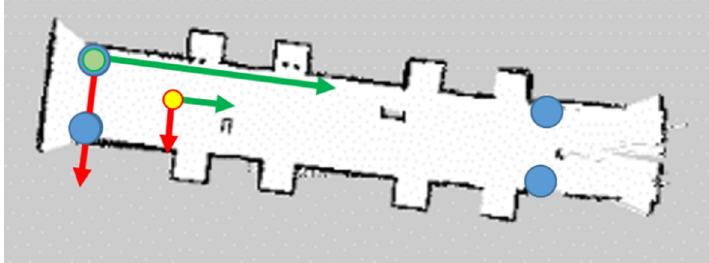
Figure 13. The distribution of the UWB system with a start point (yellow) and anchors